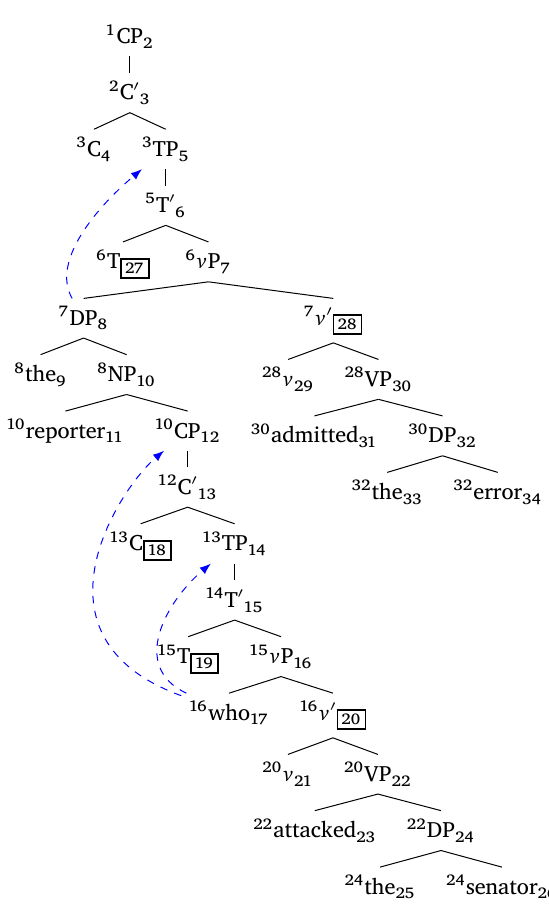
Figure 9: English SRC, wh-movement